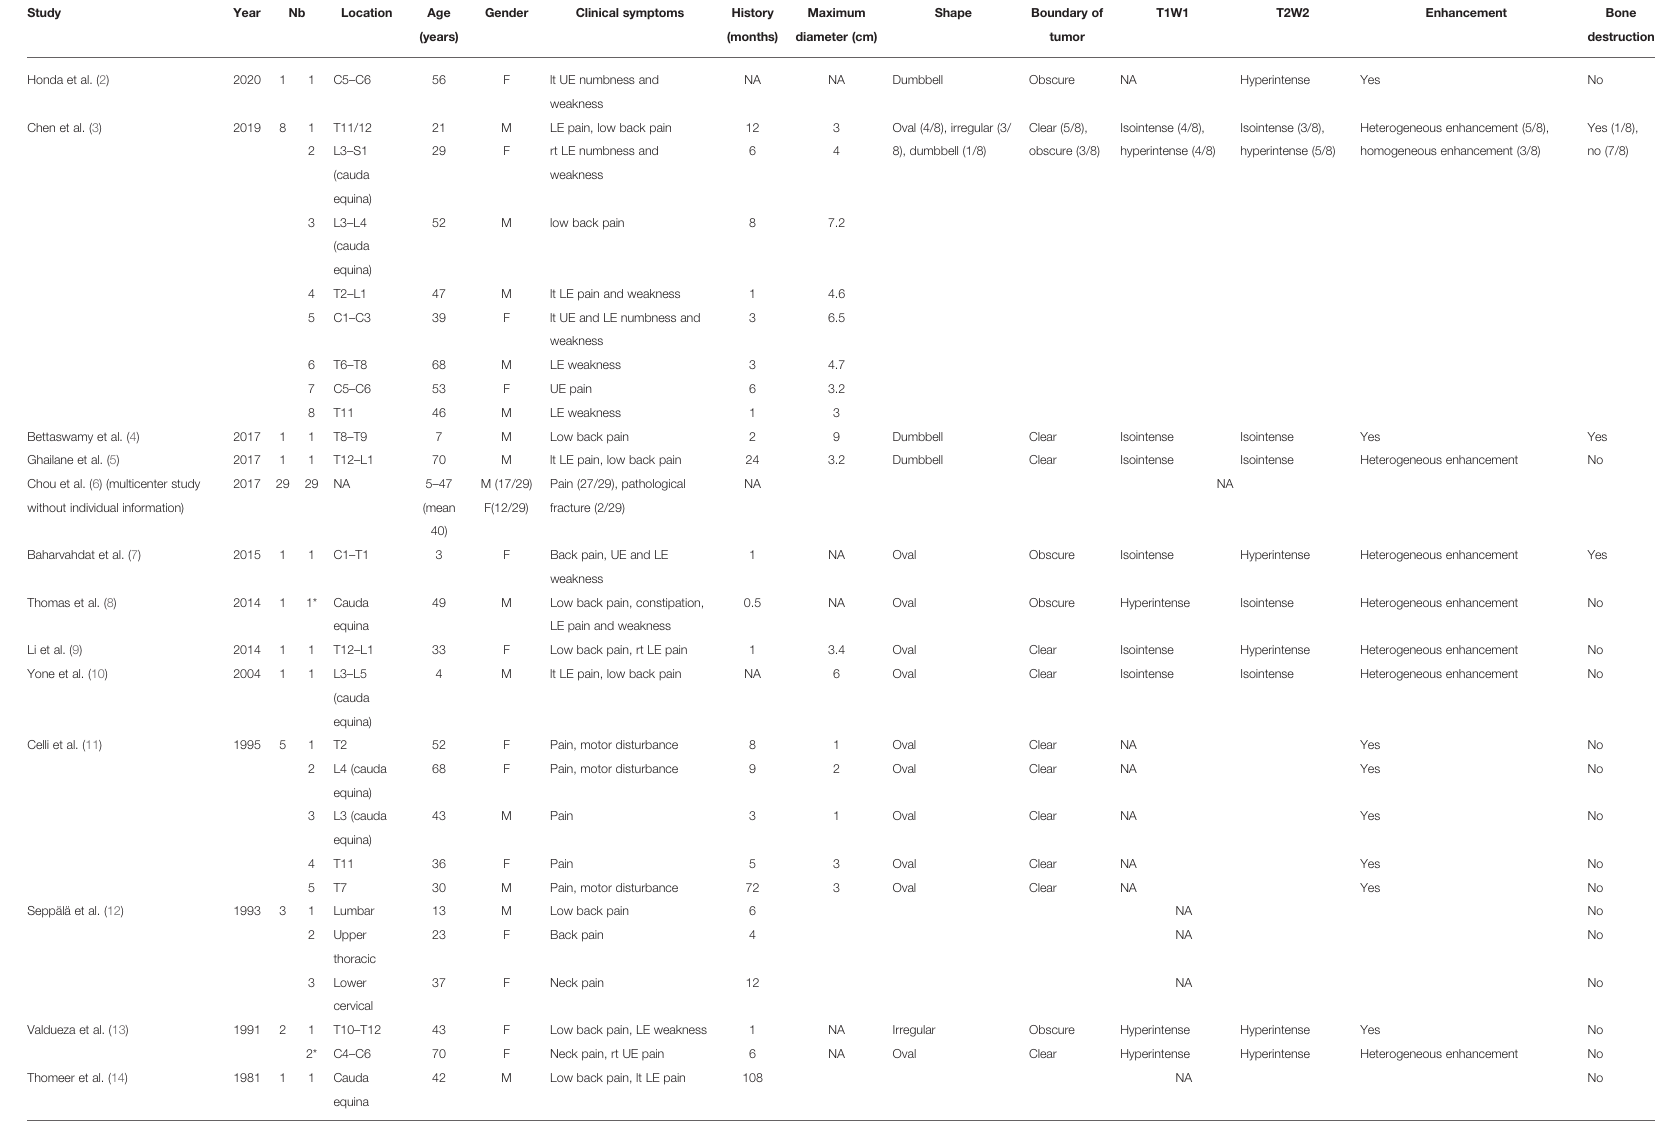
TABLE 1 | The demographic and clinical characteristics of these